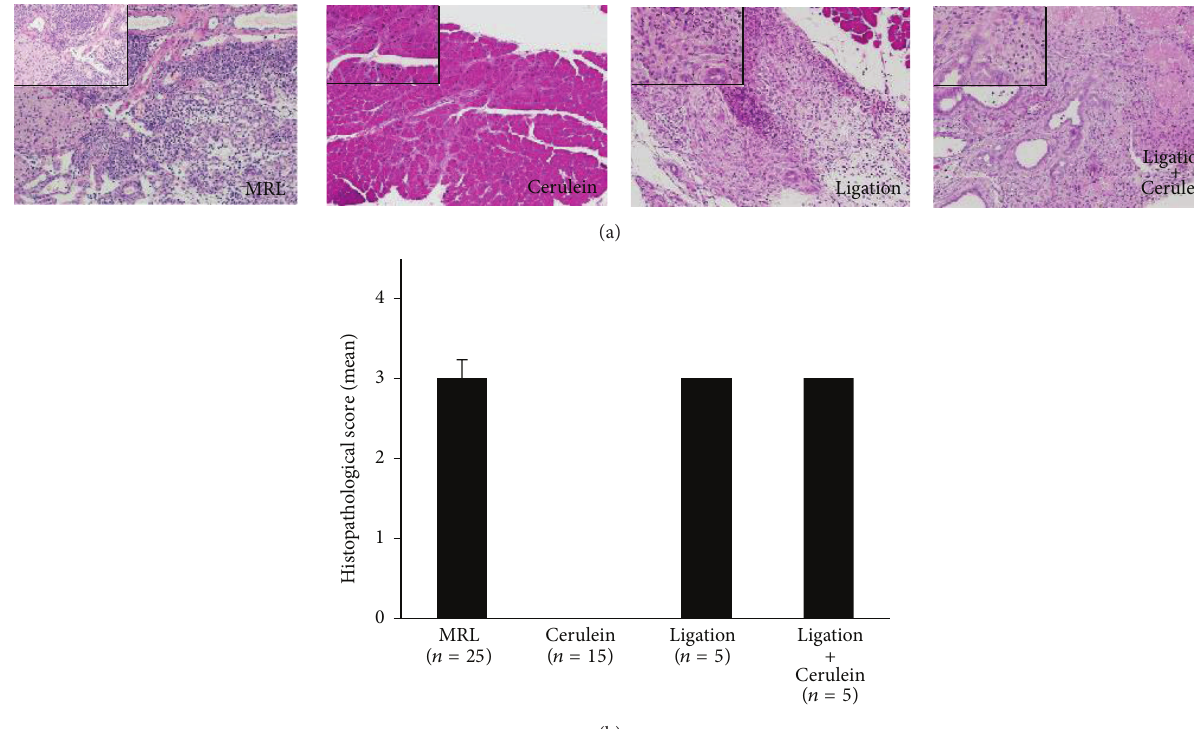
Figure 6: Representative H&E stained histological sections of the pancreases (a) and histopathological score of the pancreases (b) in poly I:C-treated MRL/Mp mice at the age of 10–20 weeks, along with Cerulein-, Ligation-, and Ligation + Cerulein-treated mice. In MRL/Mp, Ligation-, and Ligation + Cerulein-treated mice, representative pancreatic tissues showed diffuse parenchymal destruction, but with some parenchymal residue retained intact (grade 3). In Cerulein-treated mice, only slight edema was detected in the interstitium (grade 0). × 100 magnification (large panel), × 400(inset). Data are expressed as mean ±